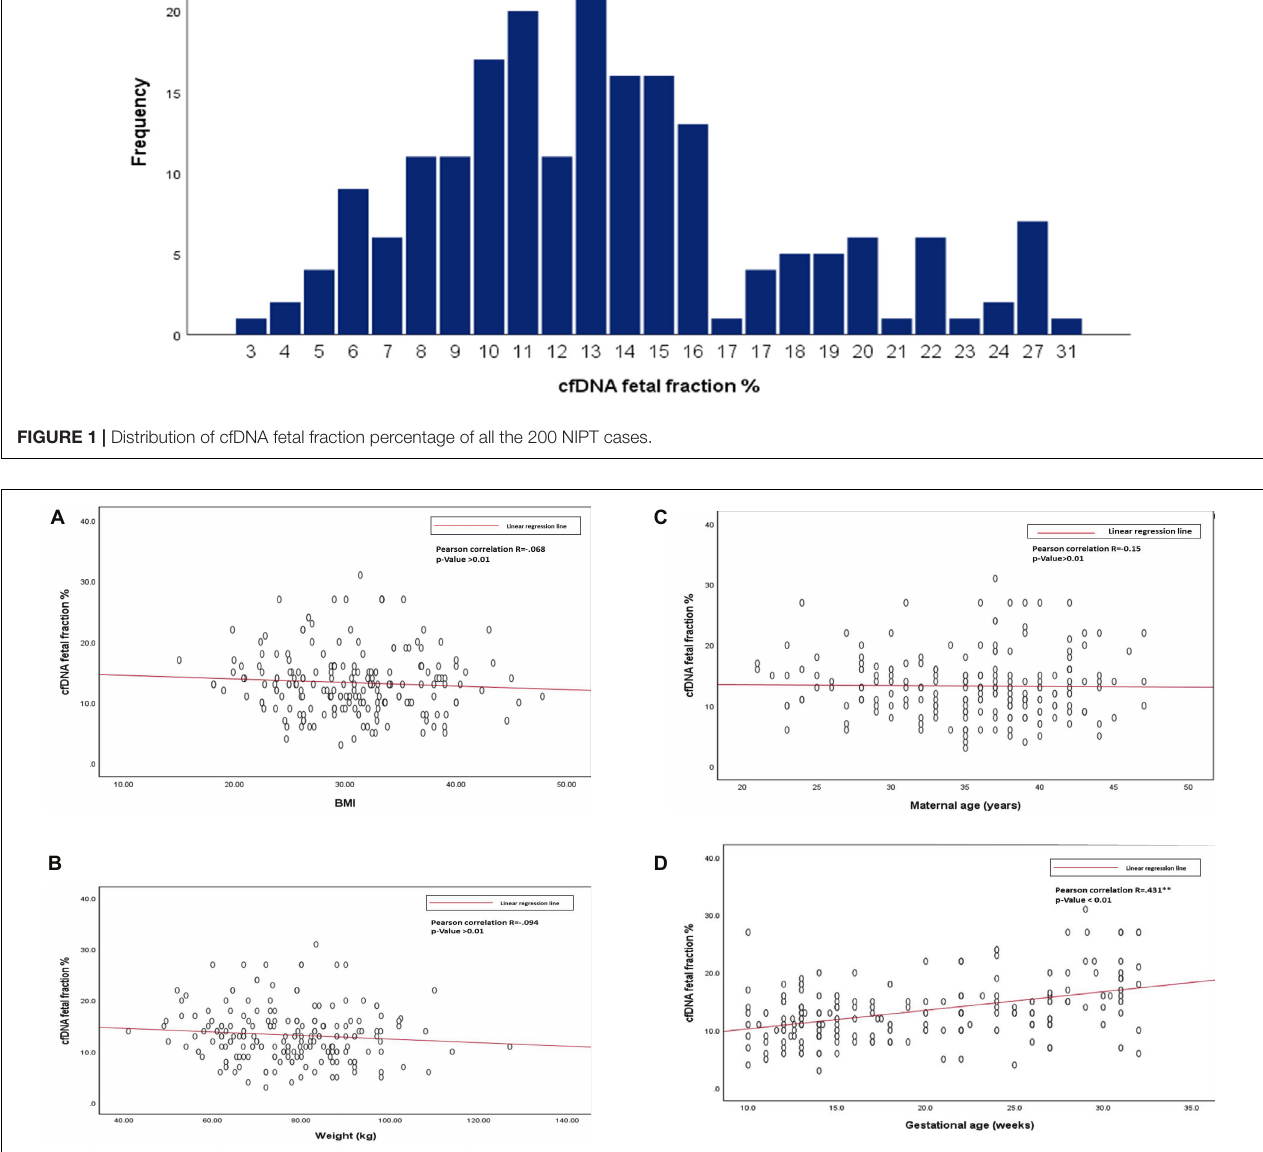
FIGURE 2 | (A) Scatterplot of BMI and cfDNA fetal fraction. (B) Scatterplot of body weight and cfDNA fetal fraction. (C) Scatterplot of maternal age, and cfDNA fetal fraction. (D) Scatterplot of gestational age and cfDNA fetal fraction.